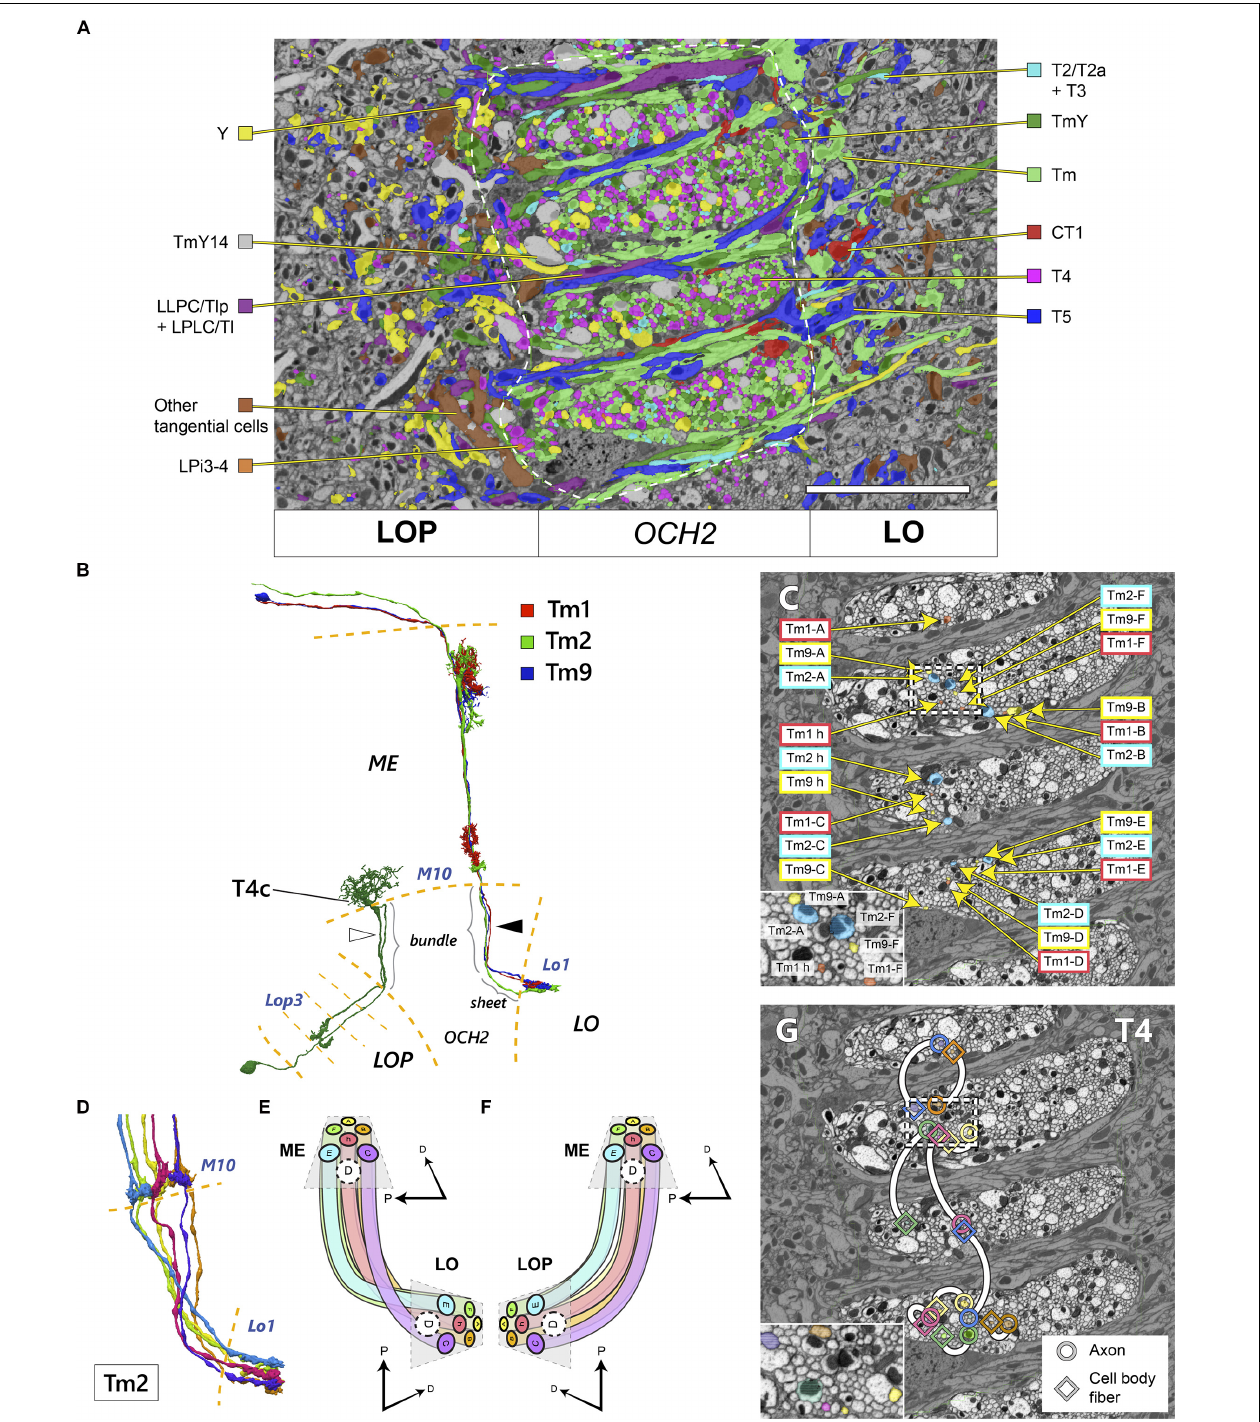
FIGURE 4 | Topology of neurons in OCH2 pathways. (A) Distribution of different cell types in a cross-section of OCH2. “Am1 + tangential cells” include Am1 and other tangential elements including those not contributing to the chiasm. Neurons with dense core vesicles (DCV) are not color-coded. See also Table 1 and Figure 2E . White dashed line demarcates the area of OCH2 in which neurons are densely traced and annotated. (B) Reconstructed Tm cells and a T4c cell. Three Tm cells, Tm1, Tm2, and Tm9, innervate the same columns both in the medulla (ME) and lobula (LO), but are not tightly bundled in the chiasm (arrowhead), see text. The T4 cell has two fibers in the chiasm, a cell body fiber and an axon connecting the medulla and lobula plate (LOP; in this case the third layer, Lop3). Fibers contributing to the bundle or sheet in the chiasm are so indicated. These fibers do not necessarily run next to each other in the chiasm either (white arrowhead).